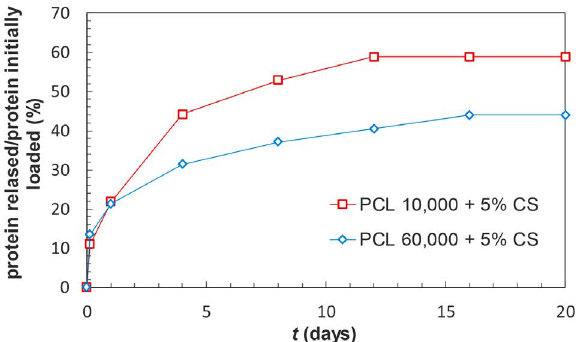
Figure 6. Total protein release normalized to the initial protein en- trapped in the scaffold (for PCL 10,000 + 5% CS and PCL 60,000 + 5% CS) vs. time of